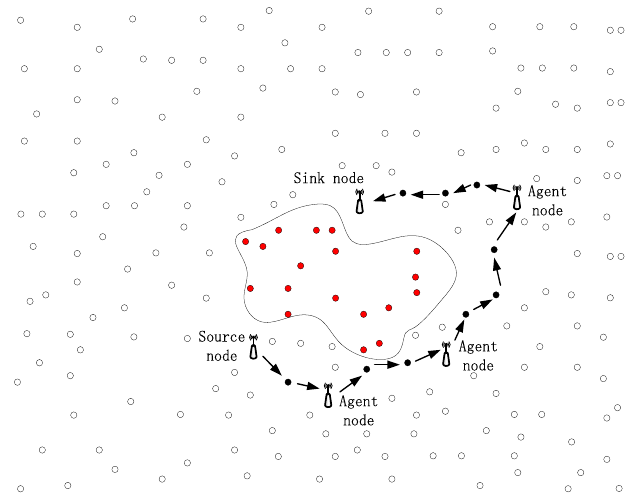
Figure 9. Updated ARR applied in WSNs with dangerous regions.